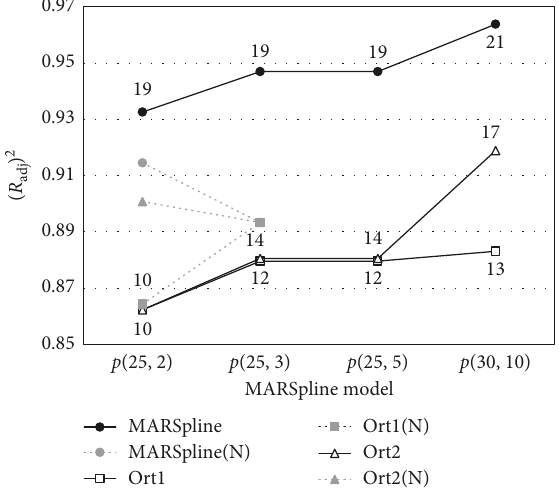
Figure 3: Results ofpredictingthevalues ofthe p descriptor, basedona series of p ( b , i ) MARSplines models. Notation is the same as in Figure